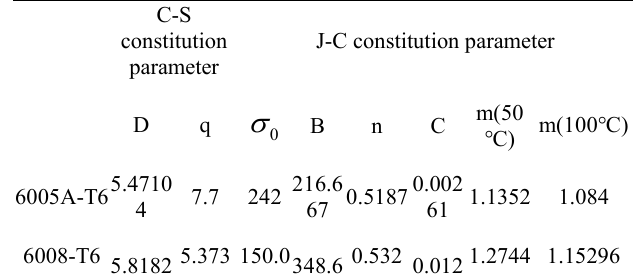
Figure 5. True stress-strain curve for 6082-T6